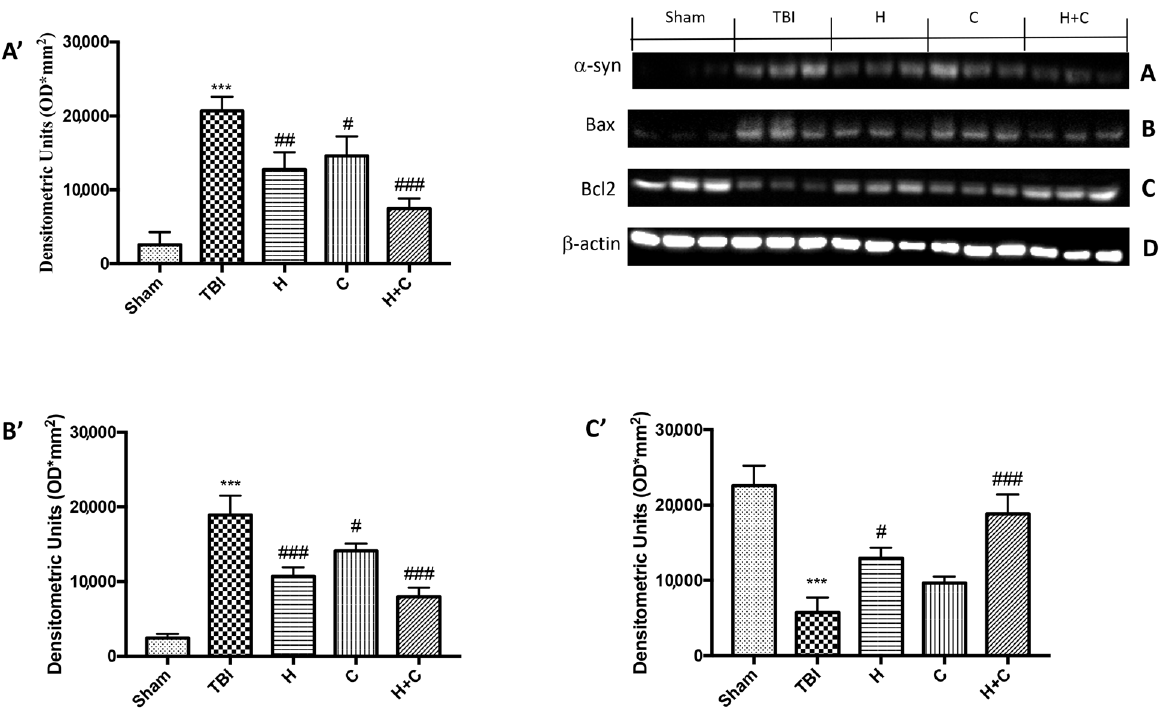
Figure 14. Effect of H. erinaceus or C. versicolor , or H. erinaceus + C. versicolor treatment on α -syn expression and apoptotic process after chronic TBI. Western blot analysis on midbrain region revealed a significant increase in α-syn in the TBI group compared to Sham animals. The H, or C or H + C treatment significantly reduced the increase in this protein ( A ). Western blot analysis demonstrated Bax expression to be significantly increased in the TBI group, whereas treatment with H, C and especially H + C significantly limited the rise in Bax expression ( B ). Finally, Bcl-2 expression was reduced after TBI; however, treatment with H, C and H + C restored the basal levels ( C ). Protein lysates were also incubated with a β- actin antibody ( D ) in order to verify that all samples had been loaded in equal quantities. The data are expressed as the mean SEM from n = 5 mice/group. Densitometry analysis: ( A’ ) *** p < 0.001 vs. Sham; ## p < 0.01 vs. TBI; # p < 0.05 vs. TBI; ### p < 0.001 vs. TBI; ( B’ ) *** p < 0.001 vs. Sham; ### p < 0.001 vs. TBI; # p < 0.05 vs. TBI; ( C’ ) *** p < 0.001 vs. Sham; # p < 0.05 vs. TBI; ### p < 0.001 vs. TBI.